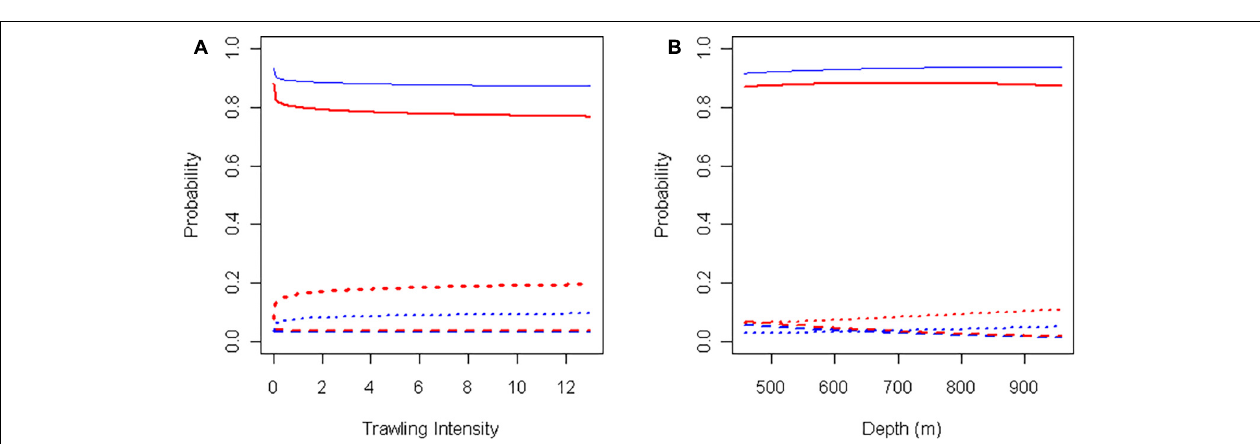
FIGURE 5 | Model predictions of the influence of trawling intensity and depth on the probability of dead/partially dead versus live Keratoisis grayi in Halibut Channel and Haddock Channel.